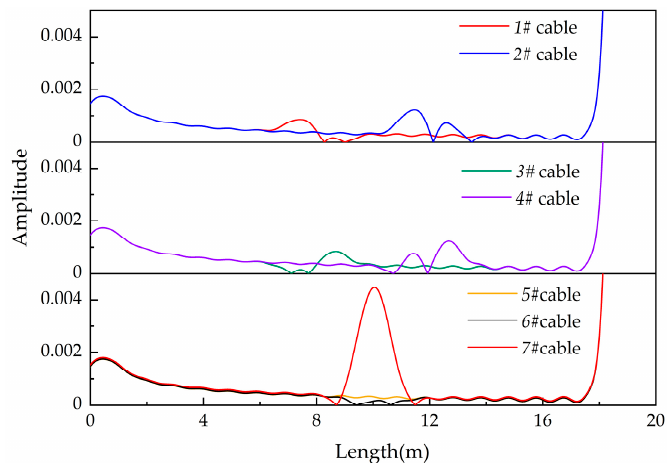
Figure 6. Location spectra of 1#–7# simulated cables.